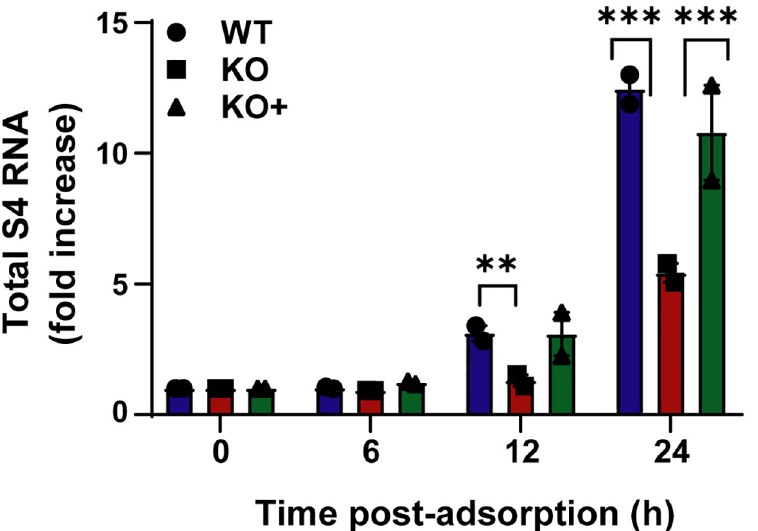
Fig 7. Synthesis of nascent RNA is reduced in NPC1 KO HBMECs. WT, KO, and KO+ HBMECs were adsorbed with reovirus virions at an MOI of 1 PFU/cell at 37˚C for 1 h, lysed at the intervals post-adsorption shown, and assayed for positive-sense reovirus s4 RNA by RT-qPCR. The results are presented as the mean number of copies of reovirus s4 RNA by qPCR from two independent experiments. Error bars indicate standard errors of the mean. �� , P < 0.01; ��� , P < 0.001, as determined by t-test.